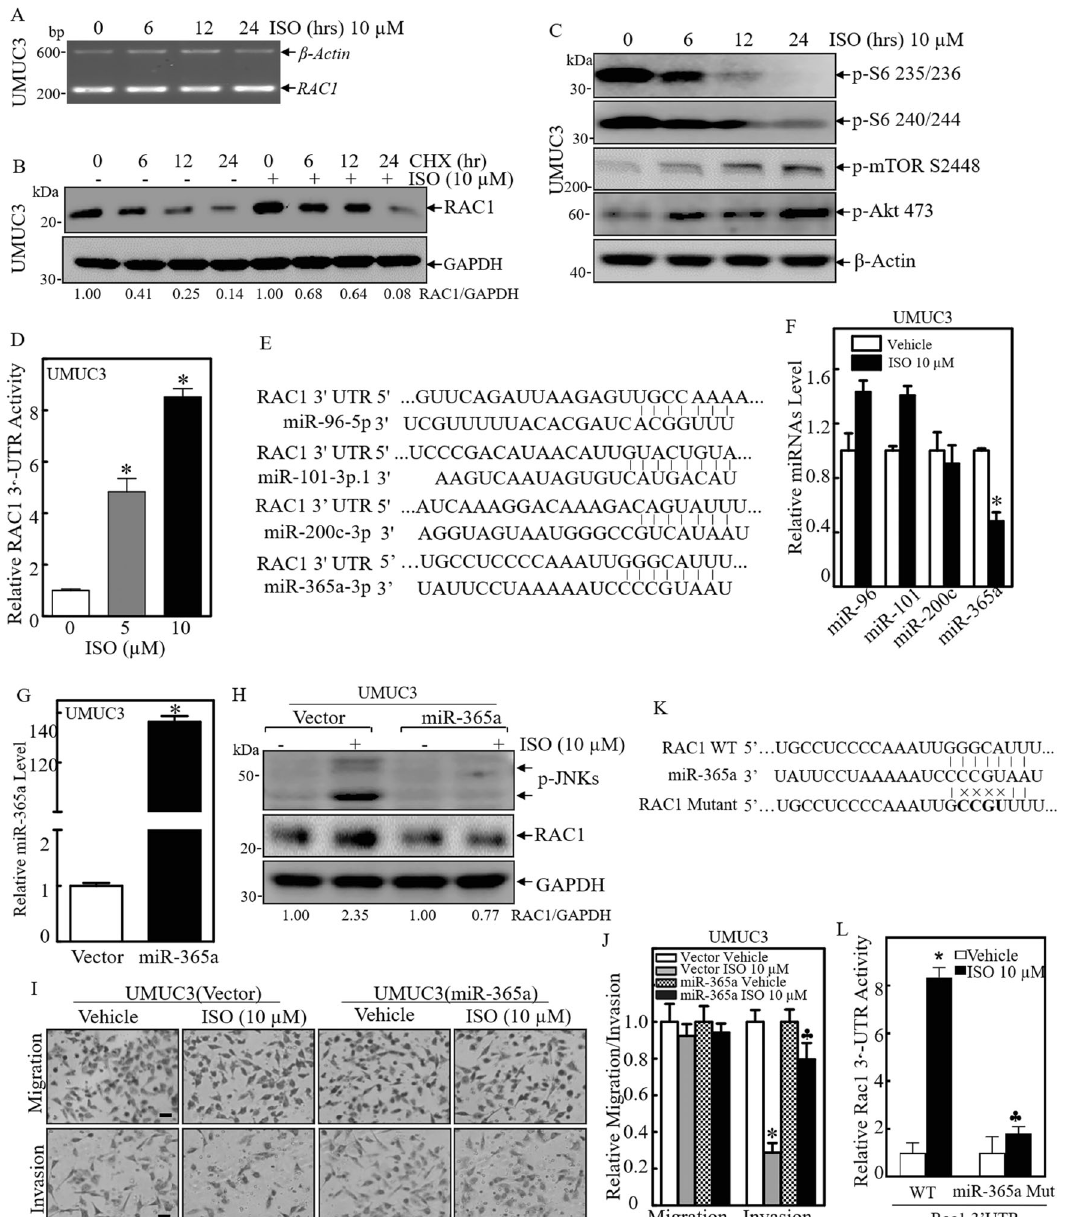
Fig. 3 Downregulation of miR-365a contributed to increased RAC1 protein translation, JNK phosphorylation and invasion inhibition following ISO treatment. A Total RNAs were isolated from UMUC3 cells treated with or without 10 μ M of ISO for indicated time periods. RT- PCR was performed to determine RAC1 mRNA levels. The β -Actin mRNA levels were used as a loading control. B UMUC3 cells were treated with cycloheximide (CHX; 100 µg/ml) combined with ISO (10 μ M) or CHX alone as indicated time periods. The cell extracts were then subjected to Western blot for determining RAC1 expression and GAPDH protein expression was used as a protein loading control. C UMUC3 cells were treated with 10 μ M of ISO for the indicated time periods. The cell extracts were subjected to Western blot to evaluate S6 phosphorylation at Ser235/236 and Ser240/244, mTOR phosphorylation at Ser2448, AKT phosphorylation at Ser473. β -Actin was used as a protein loading control. D RAC1 3 ′ -UTR luciferase reporter was transiently transfected into UMUC3 cells, and the transfectants were subjected to determine the effect of ISO on RAC1 mRNA 3 ′ -UTR activity in UMUC3 cells following 5 and 10 μ M of ISO treatment for 24 h. The results were shown as Mean±SD from three independent experiments. * Signi fi cant increase of RAC1 3 ′ -UTR activity in comparison to vehicle control ( p < 0.05). E The potential binding sites of miRNAs in 3 ′ -UTR of human RAC1 mRNA were analyzed and presented as indicated. F The relative expression levels of miRNAs were evaluated by quantitative real-time PCR in UMUC3 cells followed by ISO (10 μ M) treatment for 24 h. G Over-expression of miR-365a in UMUC3 cells was evaluated by real-time PCR assay. H The indicated stable transfectants were subjected to Western blot for determination of JNK activation and RAC1 expression with or without ISO (10 μ M) treatment for 24 h in UMUC3 cells. ( I , J ) UMUC3(miR-365a) and UMUC3(Vector) were then used for determination of their migration and invasion abilities in the presence of either vehicle or 10 μ M of ISO treatment for 24 h. K Schematic of the construction of miR-365a binding site mutant of the pMIR-Report- RAC1 mRNA 3 ’ -UTR luciferase reporter. * Signi fi cant decrease from UMUC3(Vector) treated with vehicle control ( p < 0.05 ). ♣ Signi fi cant increase from UMUC3(miR-365a) cells ( p < 0.05 ). L Attenuation of miR-365a inhibition of RAC1 mRNA 3 ′ -UTR luciferase reporter activity in miR-365a binding site mutant of pMIR- Report- RAC1 3 ’ -UTR transfectants. Results were presented as the Mean±SD of triplicates. * Signi fi cant increase from WT-reporter transfectants treated with vehicle control ( p < 0.05), ♣ Signi fi cant decrease from WT-reporter transfectants treated with ISO alone ( p < 0.05). Cell Death and Disease (2022)